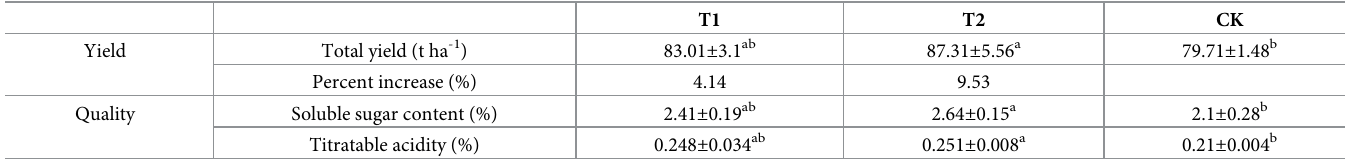
Table 4. Effects of supplemental light on tomato yield and fruit quality.